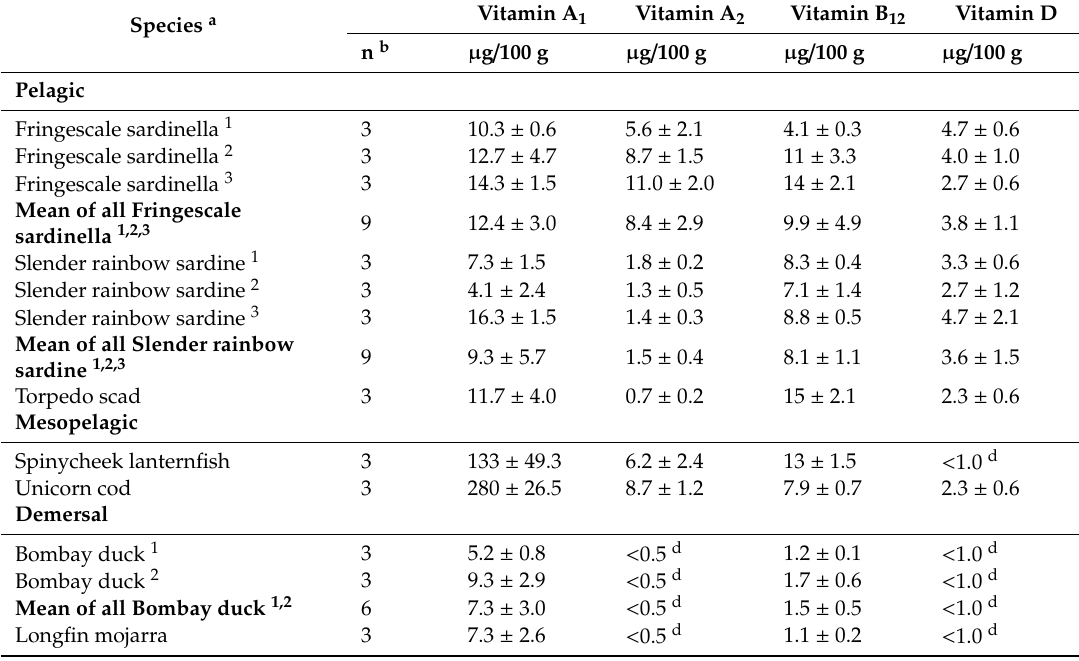
Table 5. Analytical values of the vitamin A (A 1 + A 2 ), vitamin B 12 , and vitamin D content in species sampled from Bangladesh a